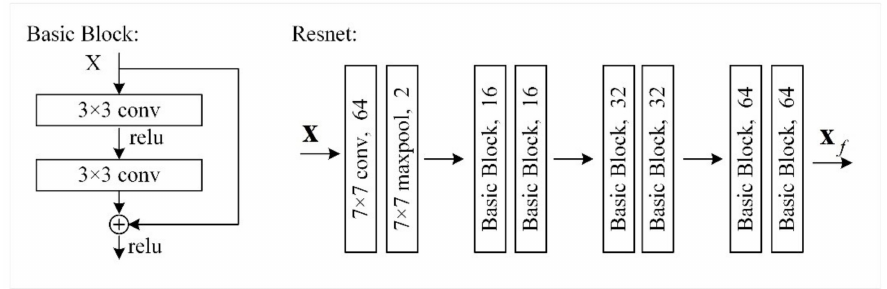
Figure 6. The architecture of Resnet. The conv represents a convolutional layer. A Basic Block is formed by cascading two convolutional layers with two relu calculations. The pooling layer is implicit in conv for pooling and down-sampling. The number after the basic block in Resnet is the dimension of the convolution